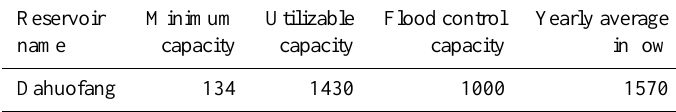
Table 1. Reservoir characteristics and yearly average inflow (10 6 m 3